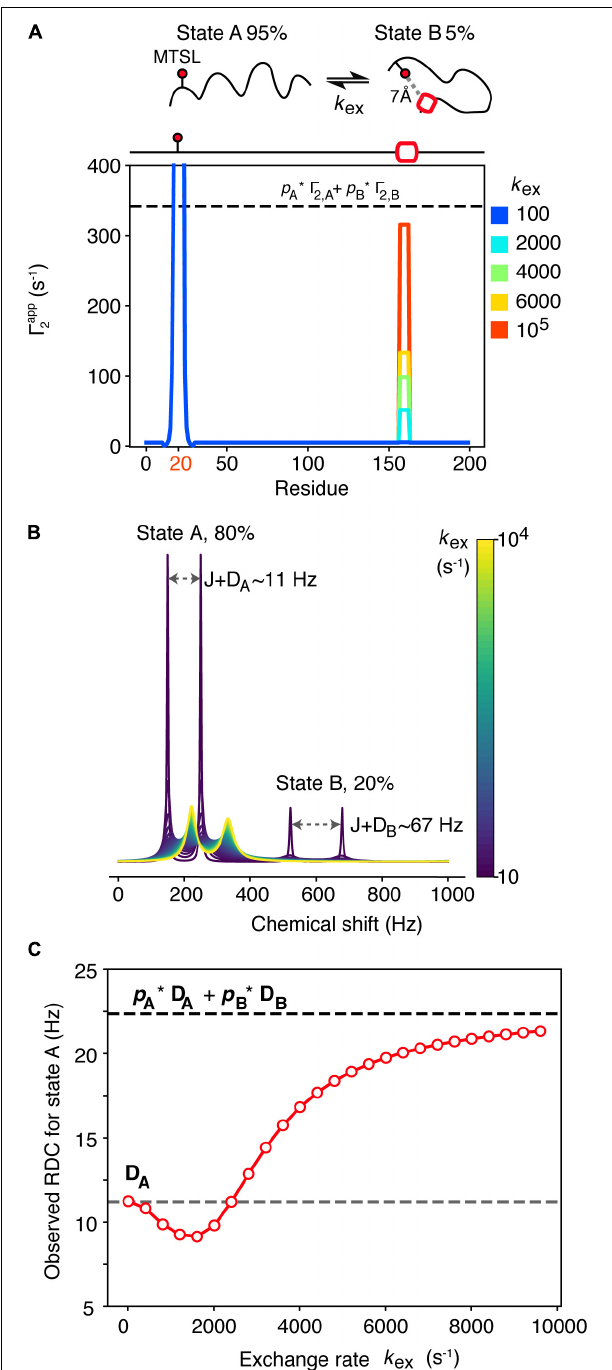
FIGURE 2 | Dependence of NMR observables often used to drive ensemble generation on the kinetics of chemical exchange. (A) A spin-labeled IDP undergoes intramolecular exchange between an expanded state A ( p A = 95%) and a more compact state B ( p B = 5%) that involves transient helix formation (red box). The 7Å distance between the spin label (placed on residue 20 of this hypothetical 200 residue protein) and the helix in residues 157–163 in state B gives rise to a PRE rate for that state, (cid:48) 2 , B = 6,750 s − 1 , while the PRE rate for state A where these residues are > 15 Å apart is